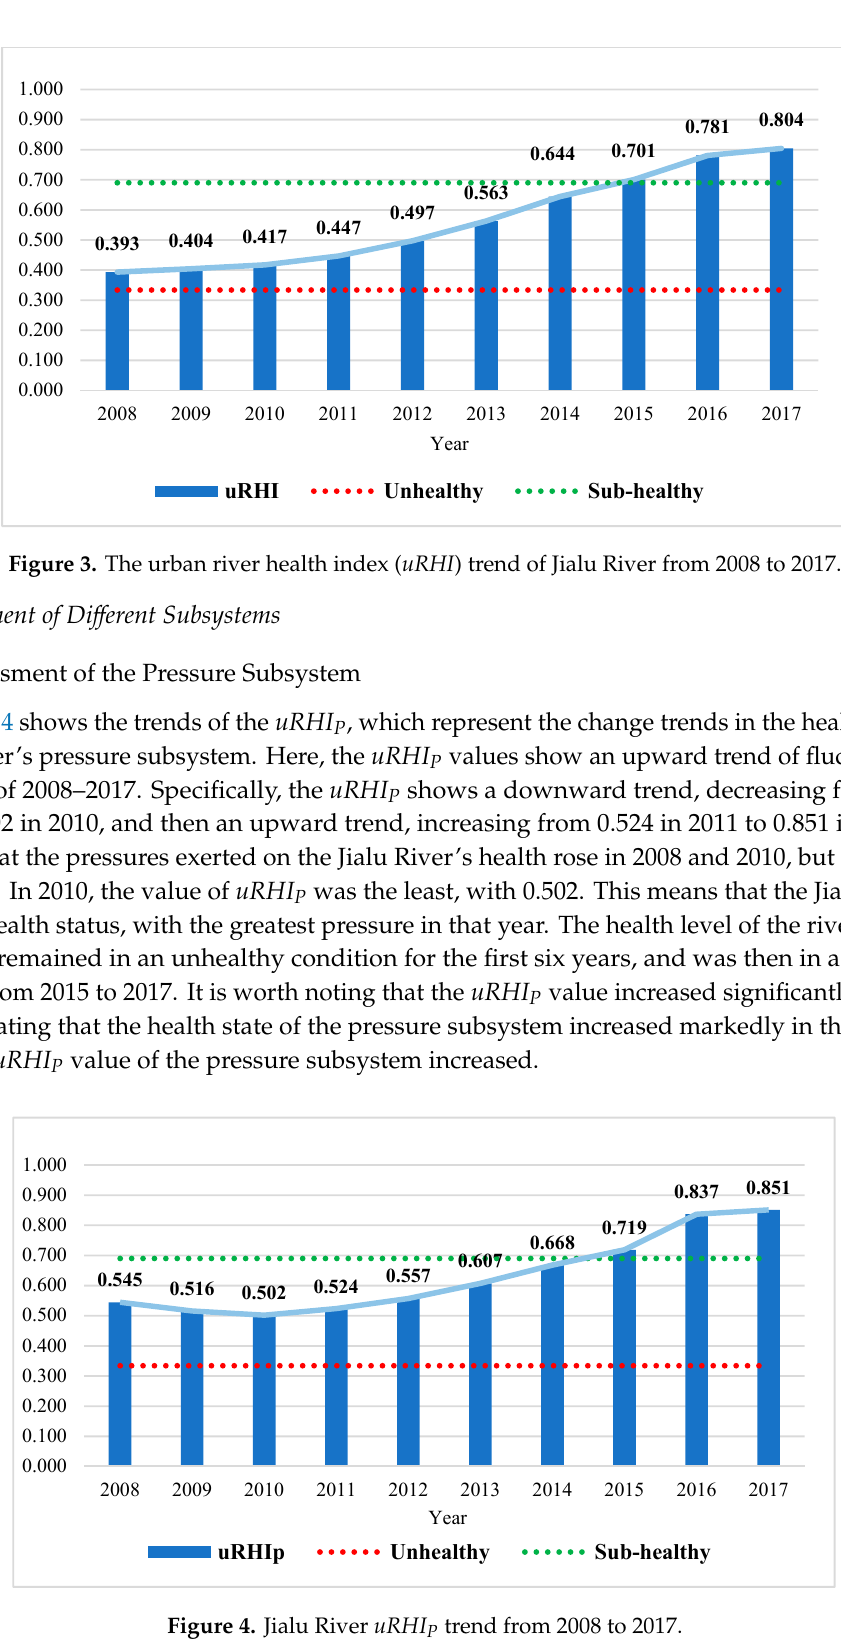
Figure 4. Jialu River